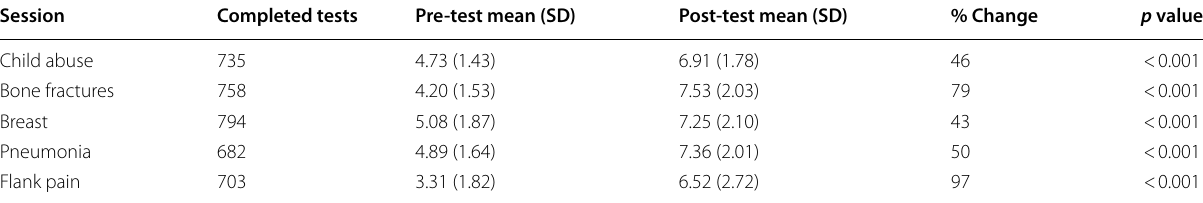
Table 2 Pre- and post-test scores by session Session